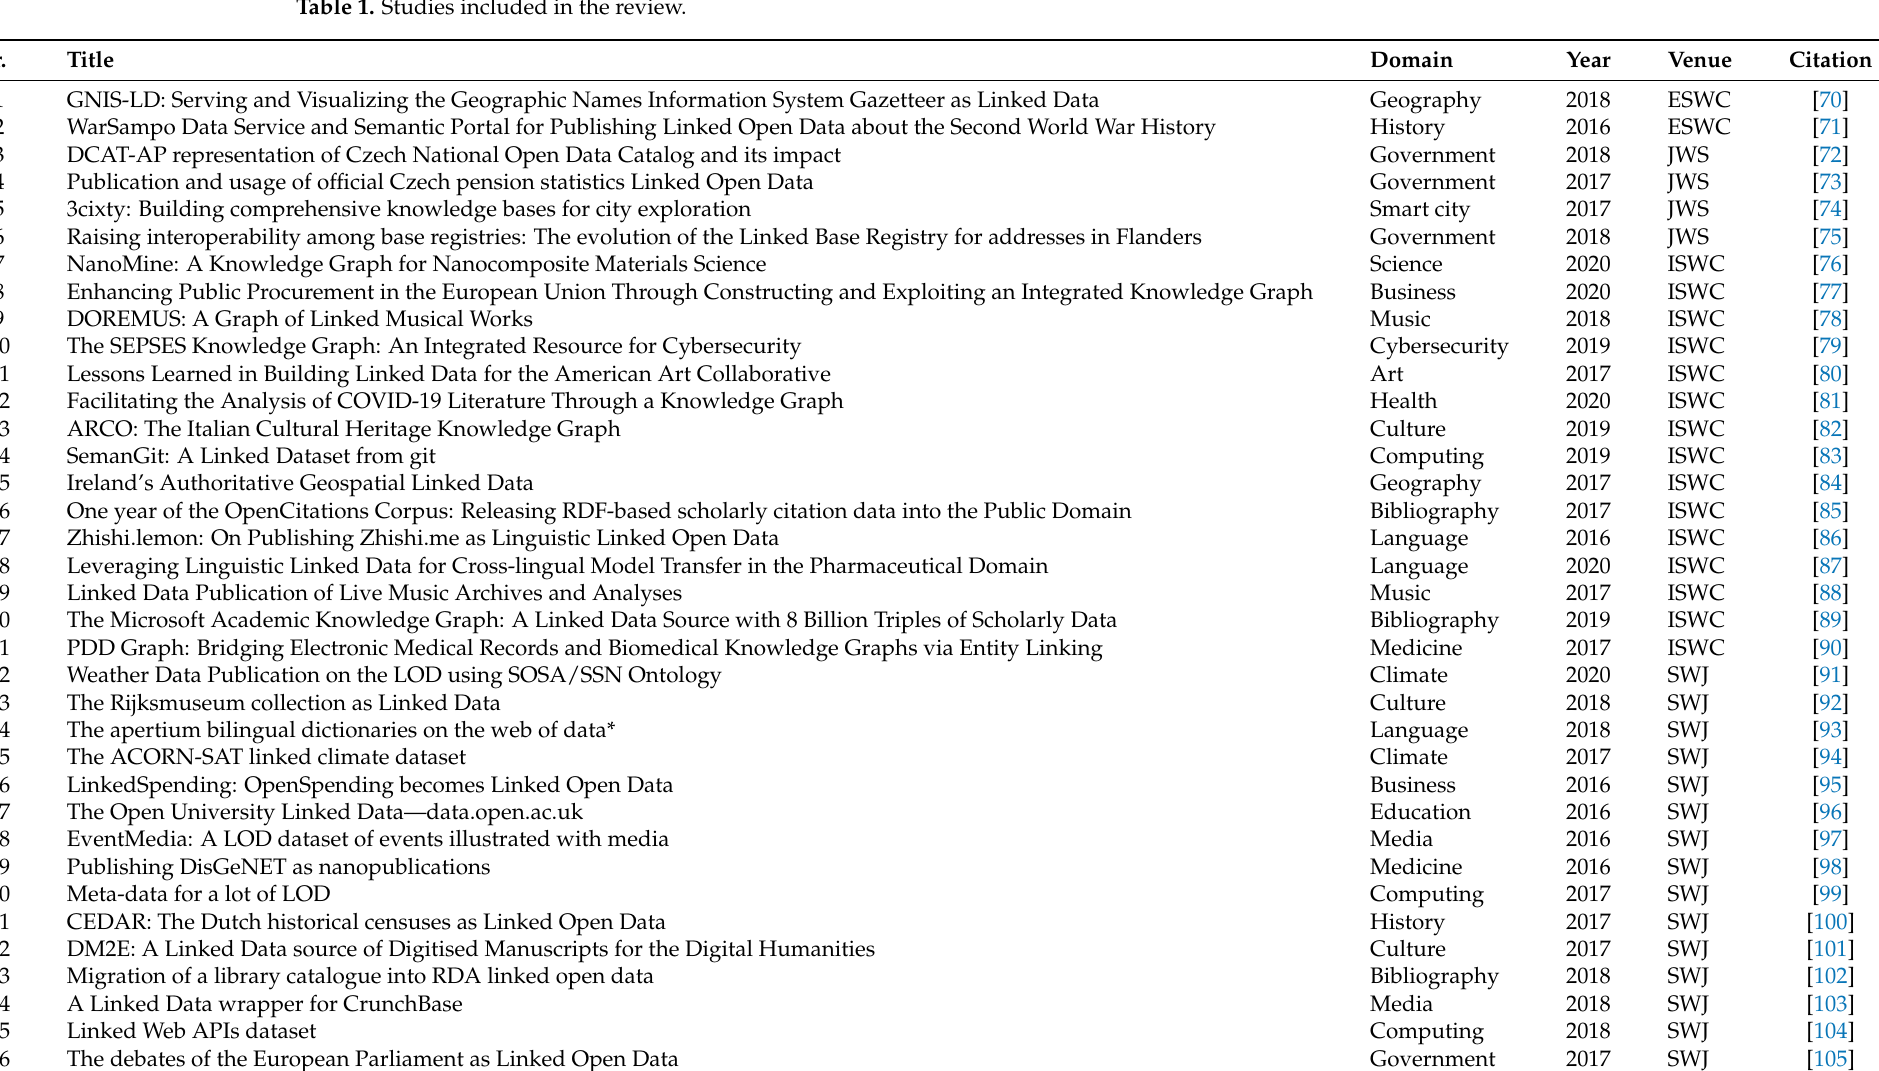
Table 1. Studies included in the